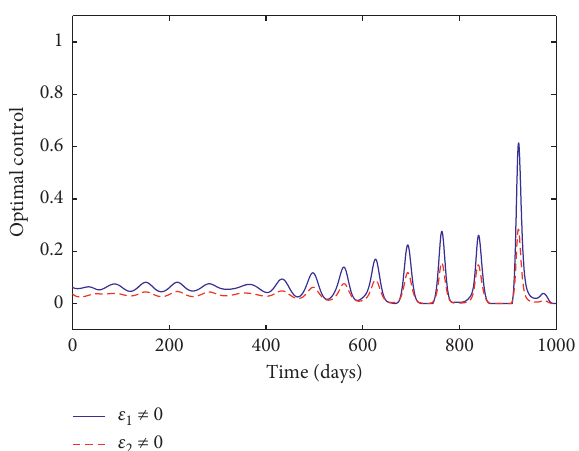
Figure 12: Optimal control strategy with ε